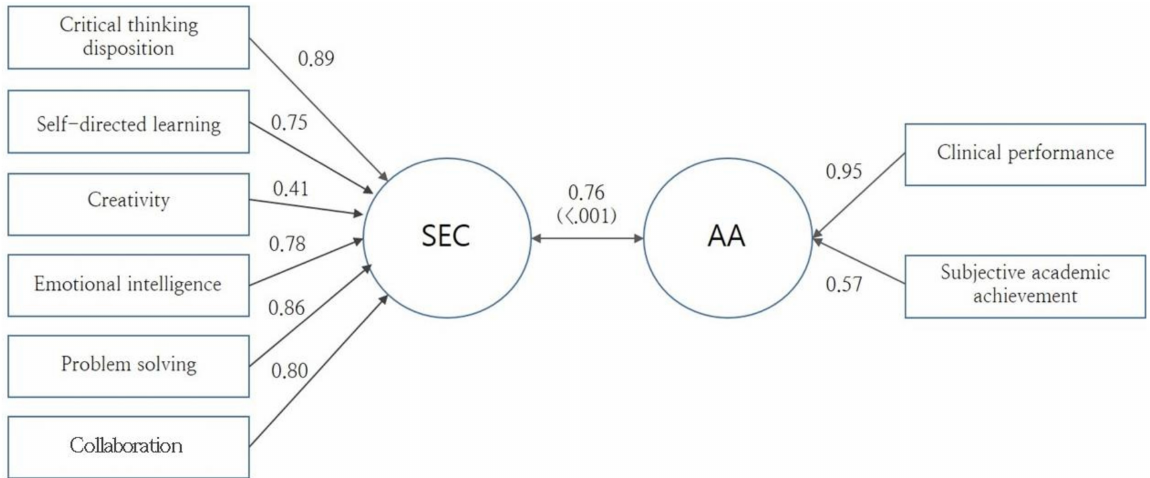
Figure 1. Structure coefficient of canonical factors. SEC: social emotional competencies; AA: academic